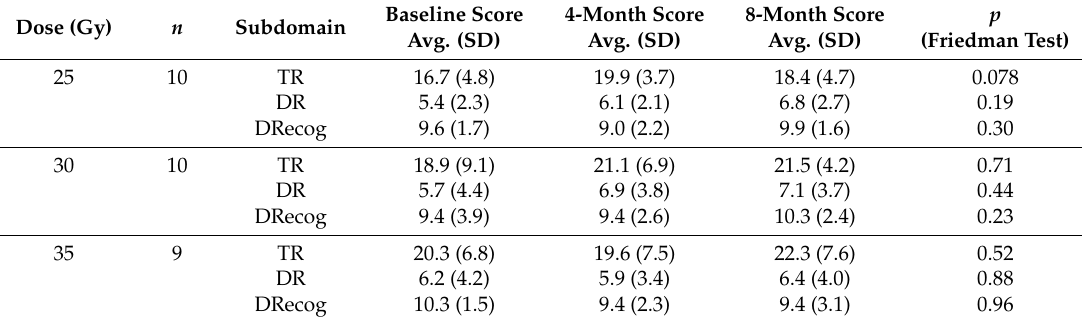
Table 4. HVLT-R scores of the patients who underwent three examinations (baseline, four, and eight months) by WBRT dose fractionation.